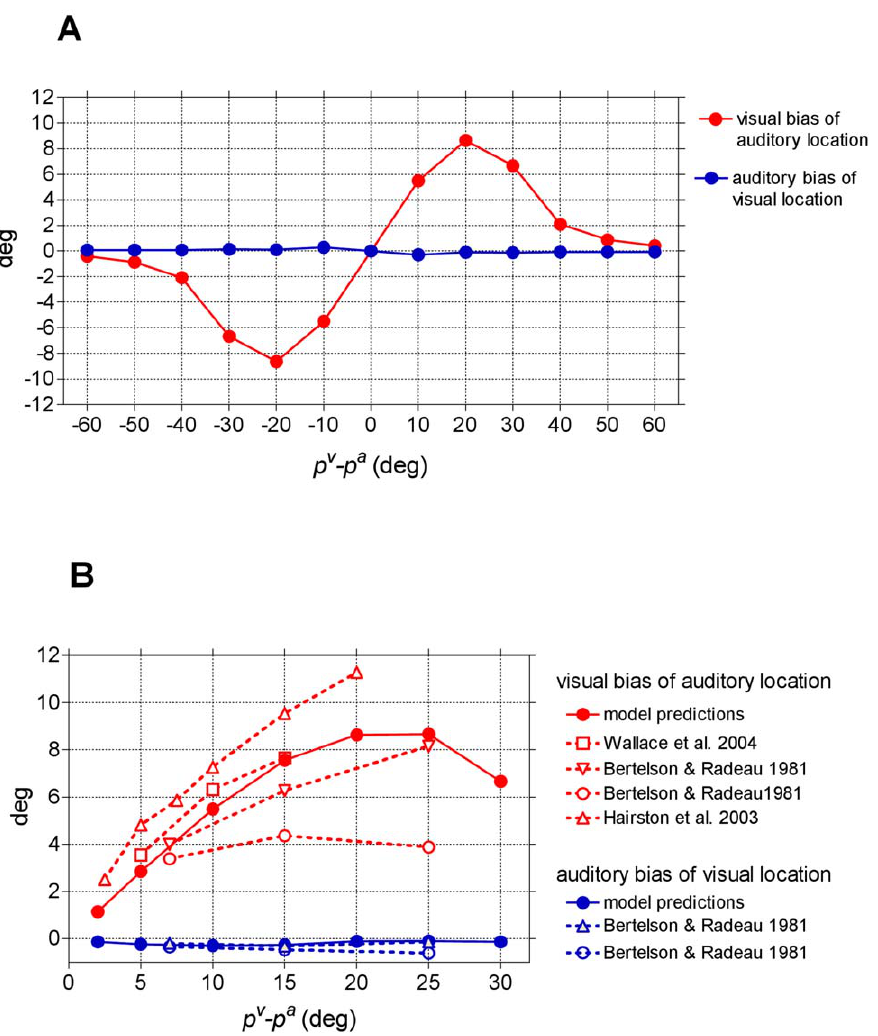
Figure 4. Visual bias of auditory location and auditory bias of visual location. ( A ) Biases predicted by the model - computed as perceived stimulus location minus original stimulus location – are displayed as a function of the angular separation between the location of the visual stimulus and the location of the auditory stimulus. The biases were computed with the vector metric when the network was in the new steady-state condition reached following stimuli presentation. The visual stimulus was maintained fixed at position p v =120 u , while the position of the auditory stimulus was ranged between 60 u and 180 u (visual-auditory angular separation ranging between 2 60 u and + 60 u ). In each simulation, stimuli have the same = E a =15). ( B ) Comparison between model predictions and in-vivo data. Biases predicted by the model (same results as (A)) are zoomed strength ( E v 0 0 between 0 u and 30 u of visual-auditory angular separation for comparison with in-vivo